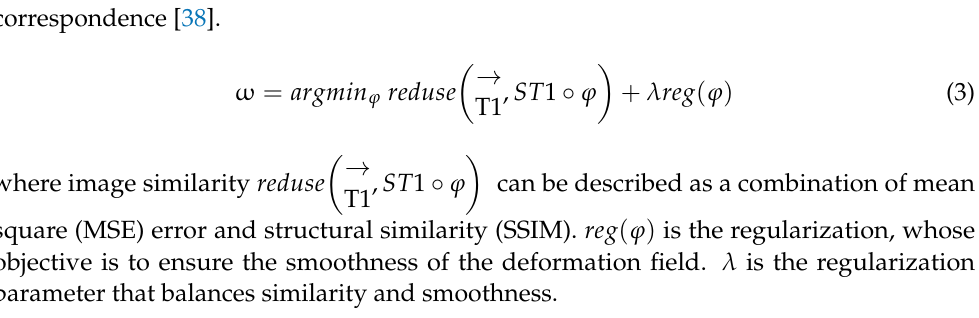
Figure 4. T1 segmentation label. A freehand spline drawing technique was used to segment all of the structures in the brain. The outline of each structure was delineated, starting with the innermost structures. By iteratively subtracting delineations to create holes, binary images were created for each structure. Segmentation was performed in a darkened room with optimal viewing conditions. The entire segmentation was inspected for correctness by an expert not involved in the segmen- tation procedure and corrections were made if needed. A third expert approved the entirety of final